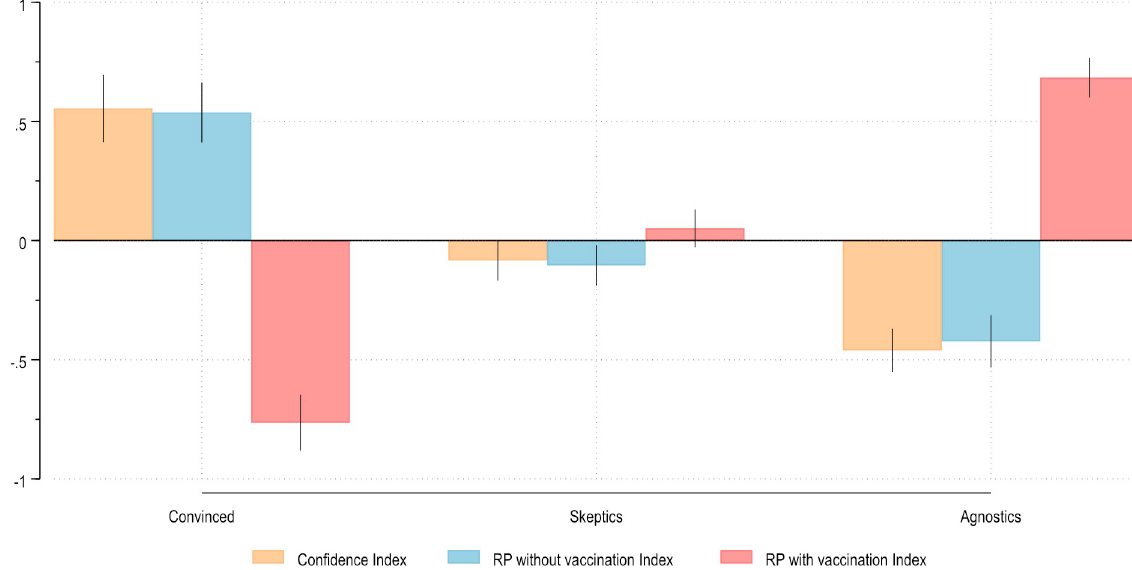
Fig 2. Average indexes’ levels by RCA groups. Average levels of confidence and risk perception with and without vaccination in each group detected by RCA. All standardized coefficients, 95%